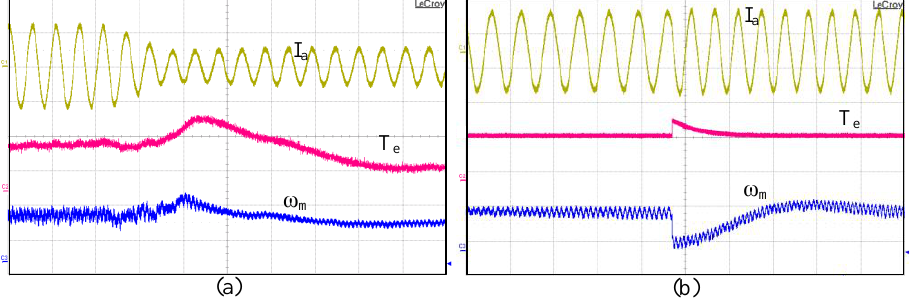
Figure 21. Dynamic response of electromagnetic torque and rotor speed for variable of ( a ) magnitude;